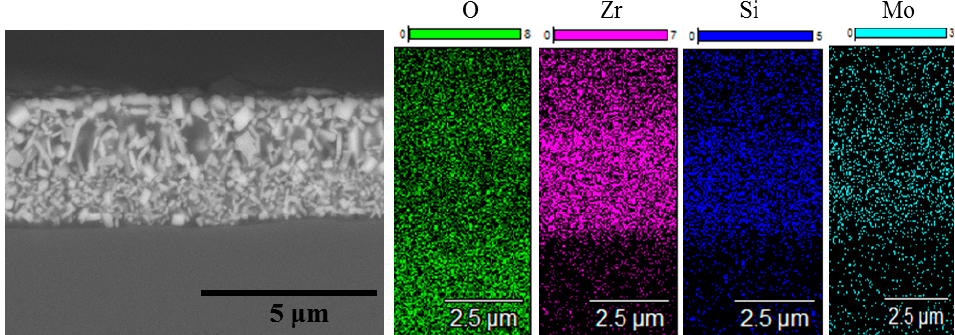
Figure 8. Cross-section SEM images of the Zr-Mo-Si-B coating (Coating 1A) after air annealing at 1000 ◦ C for 1 h. The figure illustrates protection from oxidation.